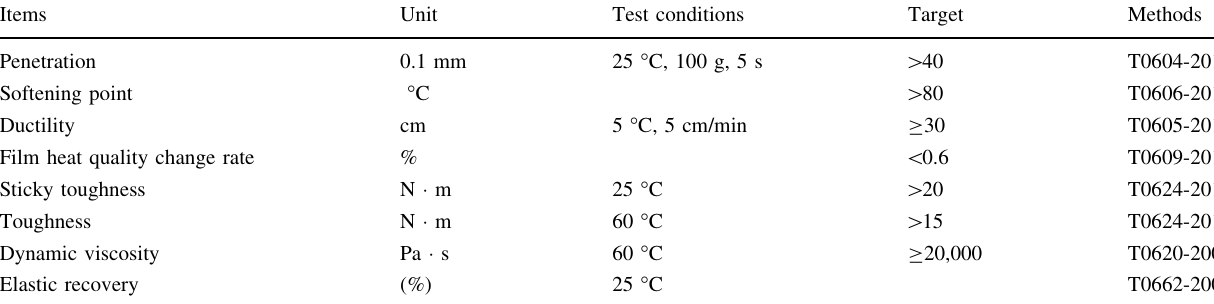
Table 5 Standard requirement of the penetration grading system of modified asphalt Items